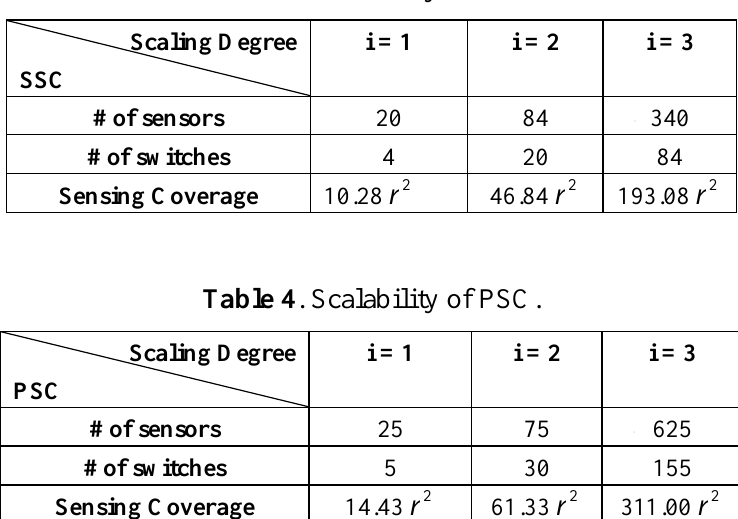
Table 3 . Scalability of SSC.